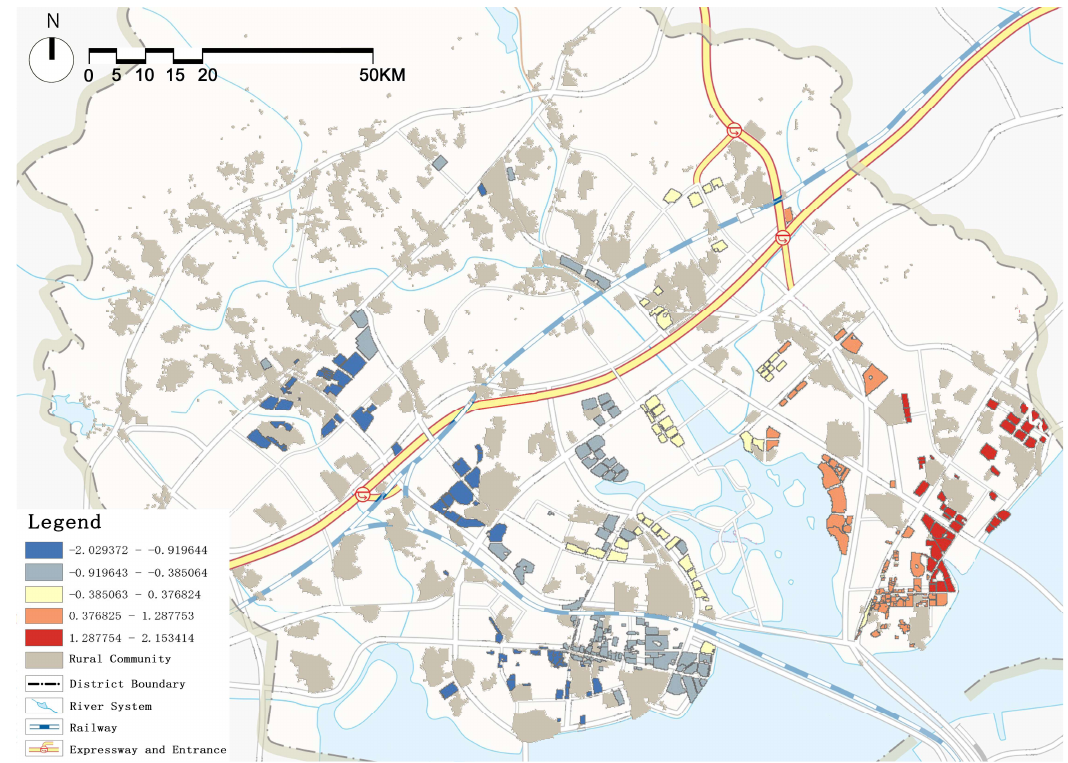
Figure 3. Spatial distribution of job accessibility.